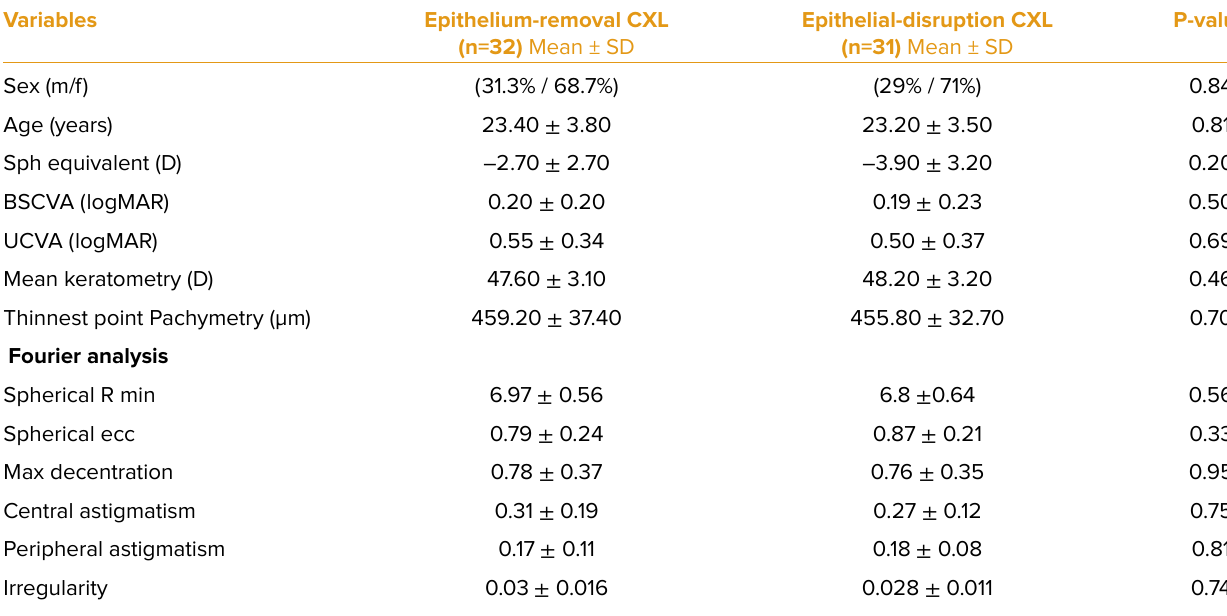
Table 1. Baseline characteristics of the epithelium removal and epithelial-disruption CXL